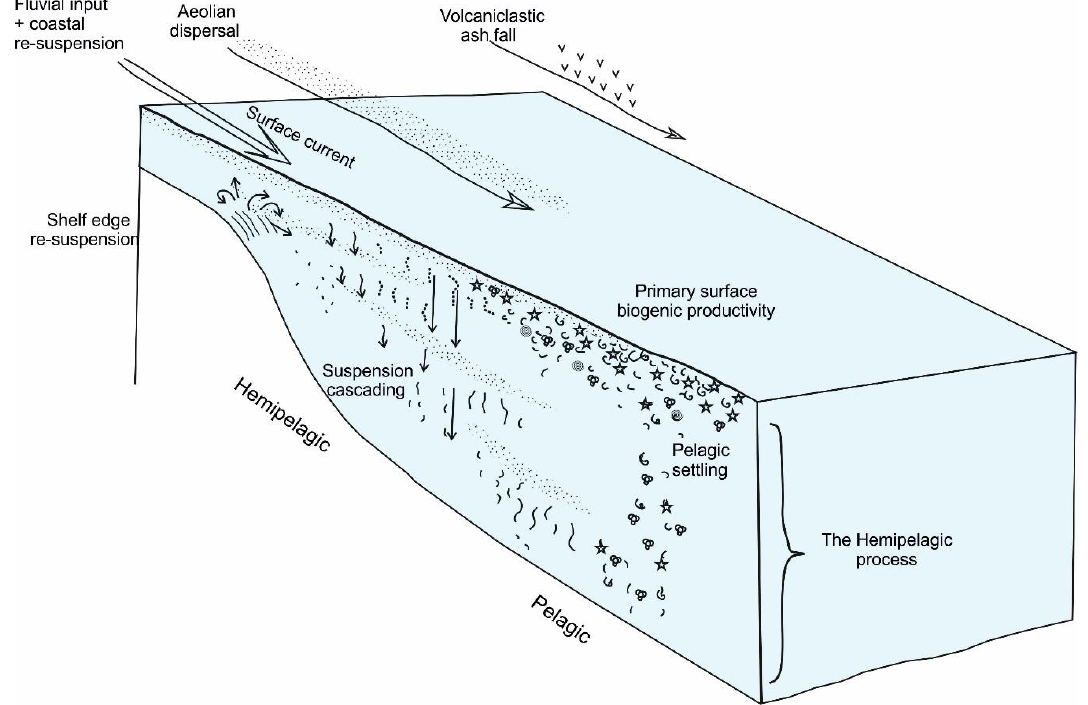
Figure 5. Schematic view (3D) of the hemipelagic and pelagic processes, identifying sediment supply from terrigenous and biological sources as well as its dispersion and settling through the water column. Typical physical parameters as shown.